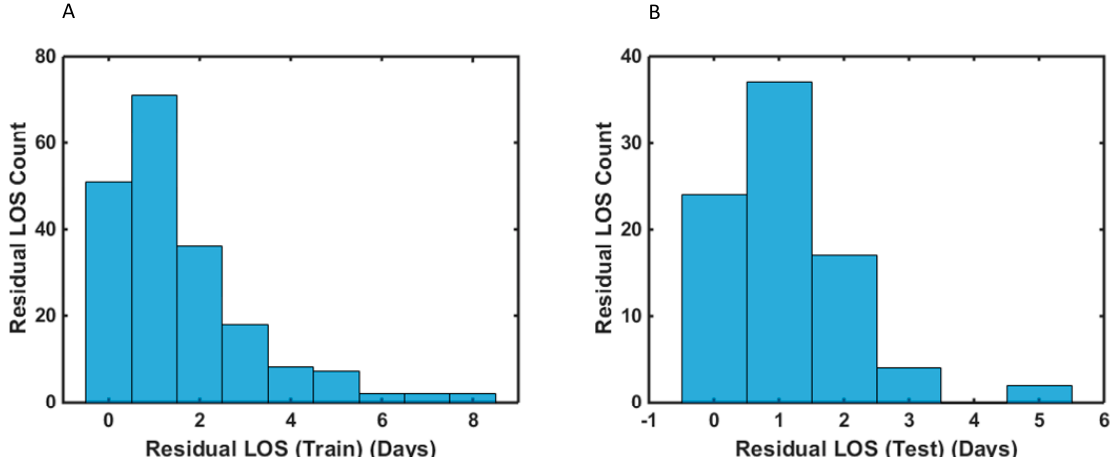
Figure 2. Histograms of the residual length of stay (LOS) distribution of advanced-stage HGSOC patients following their cytoreductive surgery for the: ( A ) training ( B ) test samples. Residual LOS is the difference between the observed LOS values and the model-predicted LOS values.